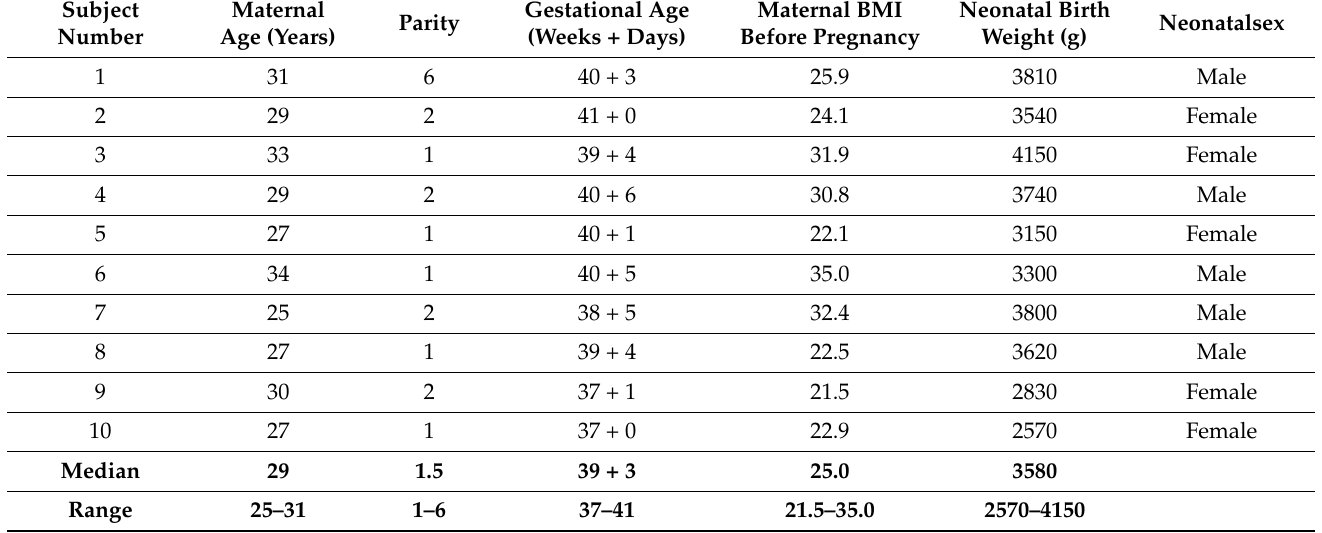
Abbreviations: BMI, body mass